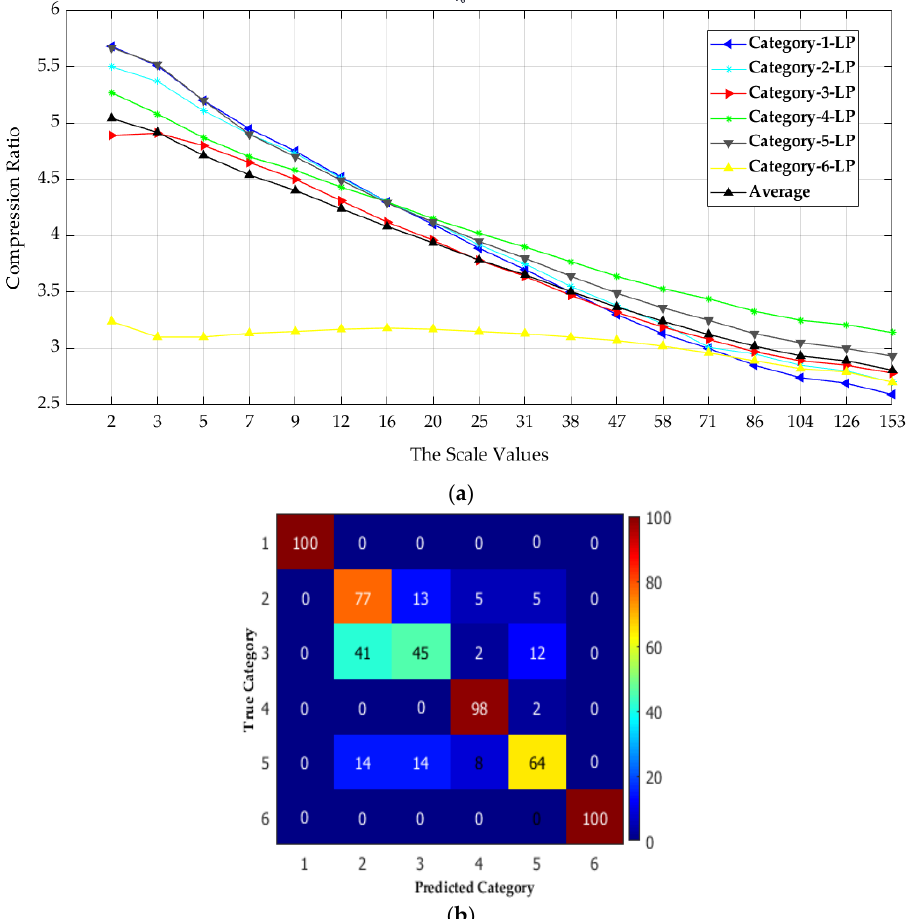
Figure 26. The impact of scale of analysis on the performances of a compressed-domain classifier: ( a ) the relation between the scale of analysis and the six surface categories’ compression and classification performances by using the multiscale LP data sets and ( b ) a confusion matrix for six surface category. classifications by using 50% of the highest-scale LP data set for training.